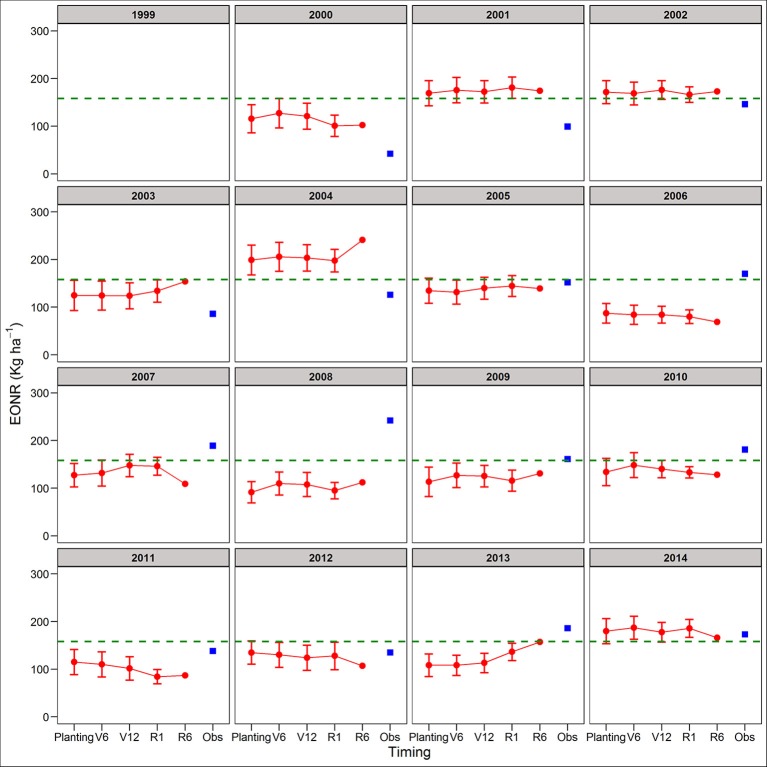
Predicted and observed economic optimum N rate (EONR) for soybean-corn. The connected red dots indicate APSIM model predictions at planting time, V6 (6th leaf), V12 (12th leaf), and R1 (silking) stages using actual and historical weather data (vertical bars indicate standard deviation, n = 35). At maturity (R6), the weather is known so there is no uncertainty in yield prediction. Blue squares represent the observed EONR. The green dashed line represents the mean EONR for the study period at this site.